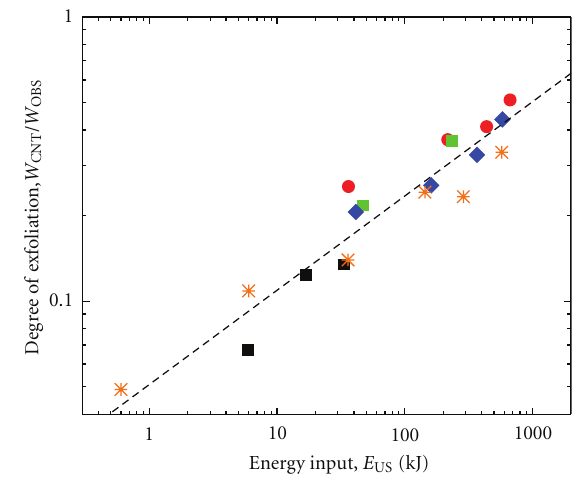
Figure 14: Mass fraction of CNTs relative to the total observed mass fraction in suspensions, W CNT /W OBS , at increasing energy input and di ff erent horn amplitudes: 10% ( (cid:2) ), 20% ( (cid:3) ), 40% ( • ), and bath sonicator ( ∗ ). Dashed line, y = 0 . 05 x 0 . 33 , shows a nonlinear curve fit of the